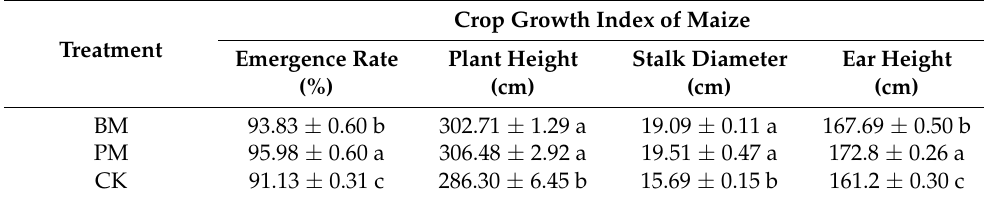
Table 1. Agronomic characters of maize covered with BM paper film and PM white film.